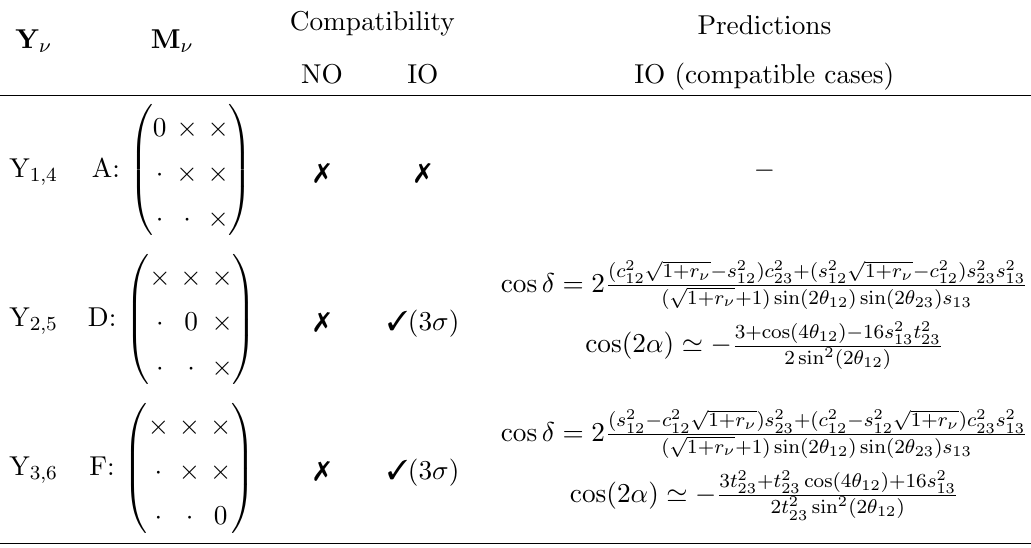
Table 3 . Textures for the e(cid:11)ective neutrino mass matrix M (cid:23) obtained with the seesaw formula (2.4), considering the Y (cid:23) textures of eq. (3.3) and the pattern R 4 for M R . The ‘ 3 ’ and ‘ 7 ’ symbols indicate whether or not the corresponding texture is compatible with data. Hereafter, r (cid:23) (cid:17) (cid:1) m 2 instance, in the simplest case of diagonal Y with eq. (2.11) and O given by eq. (2.25), leads